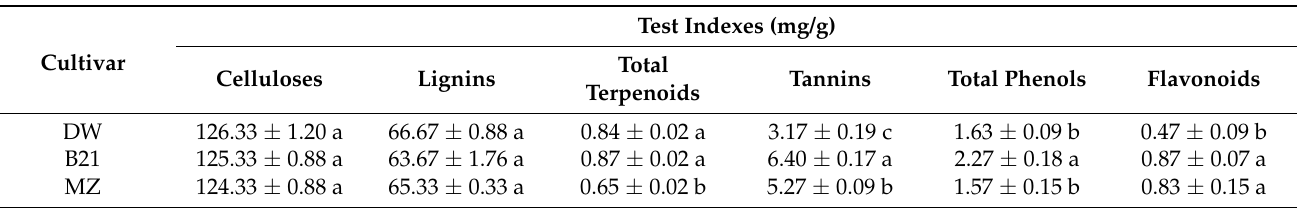
Note: Different lower letters represent the significant difference among hazelnut cultivars at the level of p < 0.05.